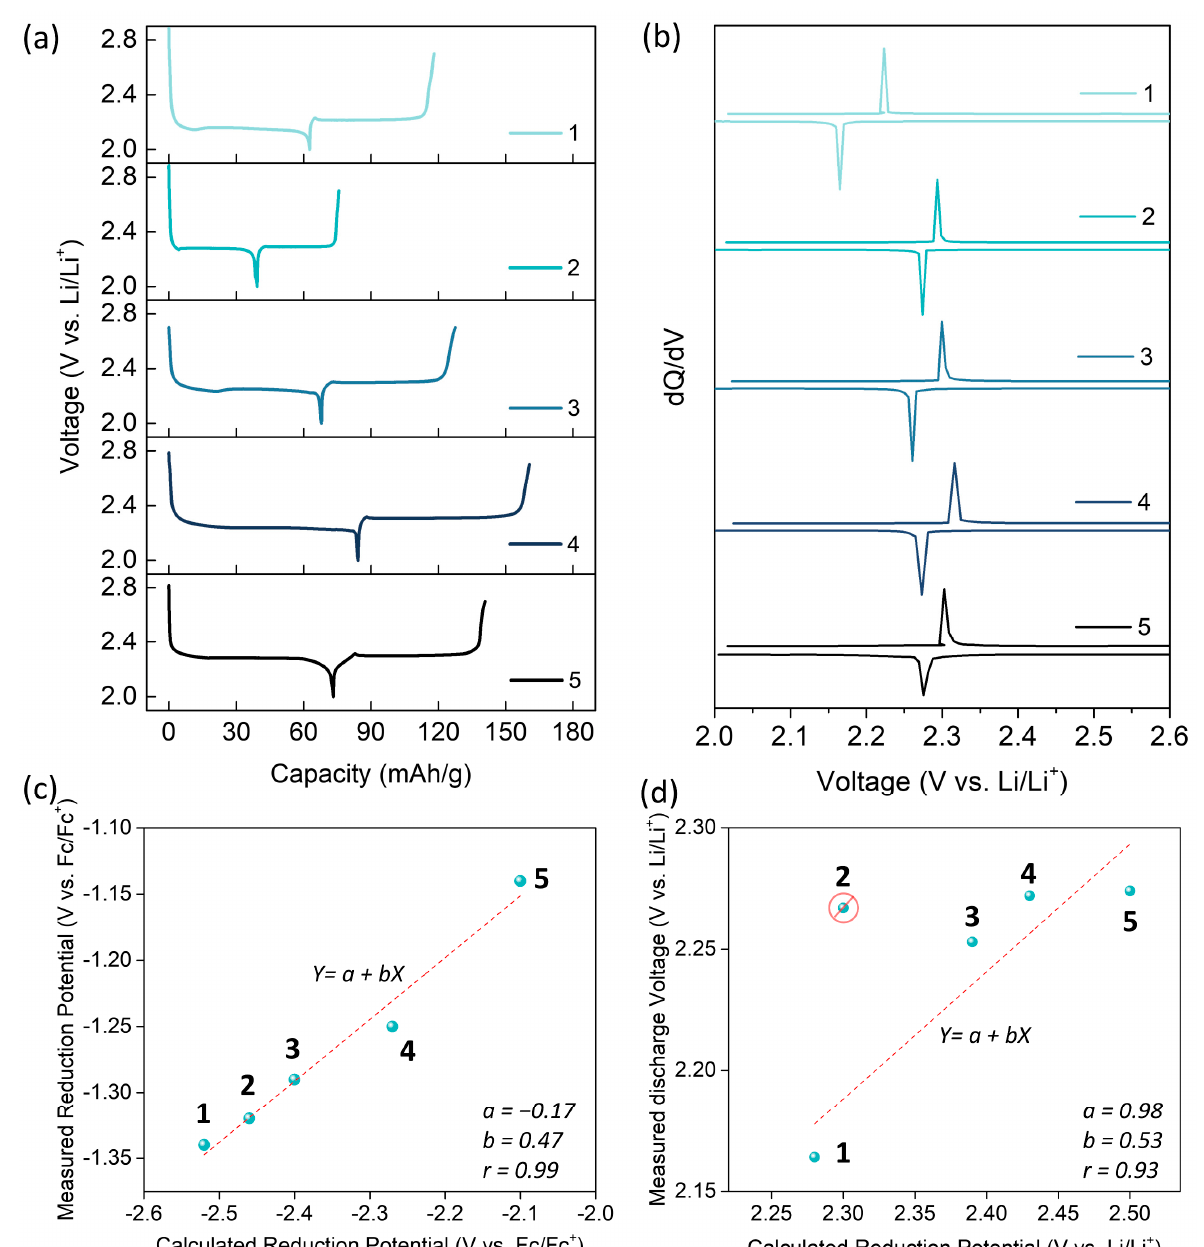
Figure 3. ( a ) The galvanostatic charge/discharge profiles for the s-tetrazine electrodes at 0.1 C rate. ( b ) The dQ/dV plots of the s-tetrazine electrodes. The correlation graphs about ( c ) the measured reduction potentials in CV vs. the calculated reduction potentials without considering Li-ion insertion by the DFT method and ( d ) the measured discharge voltages in Li-ion cells vs. the calculated reduction potentials considering Li-ion insertion. The dashed red lines in ( c ) and ( d ) indicate linear fitting curves and the regression coefficients are presented in the graphs. In graph ( d ), the point for the 2 electrode was excepted as an outlier for the linear regression because of the statistical reasons. See Figure S15 for the detailed analysis.